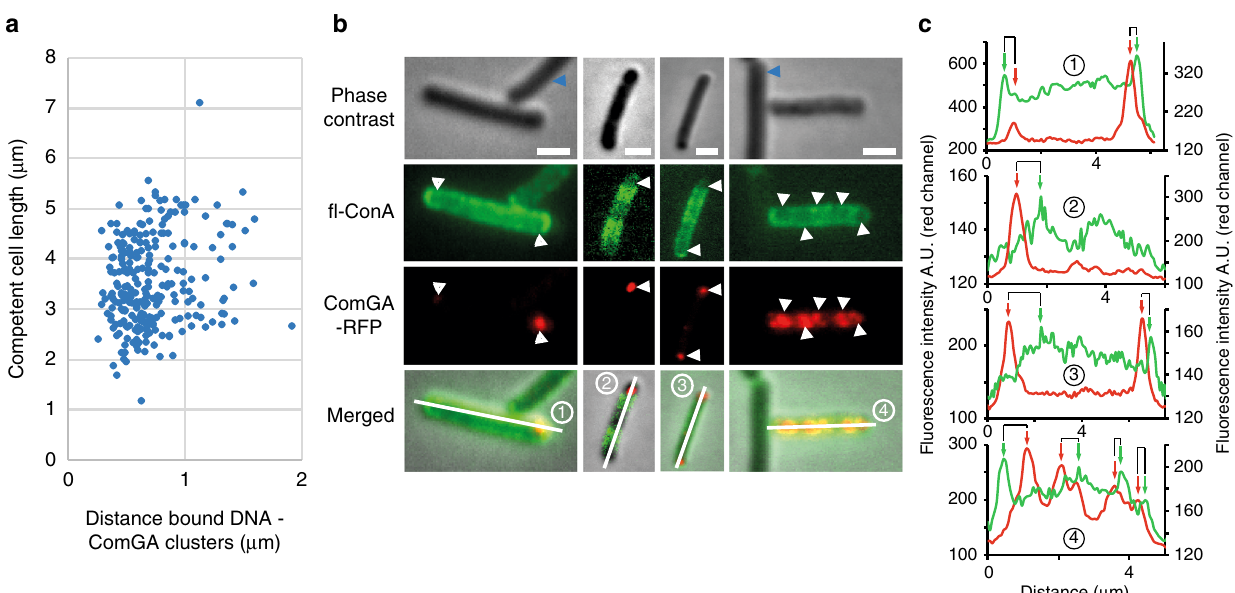
Fig. 4 WTAs distribution at the surface of competent cells. Strains NC58 ( amyE ::P comGA - comGA - gfp ) and NC118 ( thrC ::P comGA - comGA - mrfpruby ) were used to compare the distribution of ComGA and DNA binding ( a ) and of ComGA and WTAs ( b and c ), respectively, in competent cells. a Distance between bound DNA (red channel) and ComGA foci (green channel) plotted against the average cell length (strain NC58, n > 250). b fl -ConA and ComGA dual labeling (strain NC118). For each fi eld of view, phase contrast, GFP, RFP, and merged images are shown. White arrowheads point to cell locations where ComGA forms bright clusters. The fl uorescence intensity pro fi les (green and red channels) along the midline of the four cells numbered in the merged images are shown in panel c . Blue arrowheads point to non-competent cells. Scale bar, 1 μ m. c Green ( fl -ConA) and red (ComGA-RFP) fl uorescence intensity (A. U.) distributions along the midline of the four cells shown in panel b (numbered 1 to 4). Green arrows, local increases in fl -ConA intensity (peaks in the green curve). Red arrows, closest ComGA cluster to each local increase in fl -ConA staining (peaks in the red